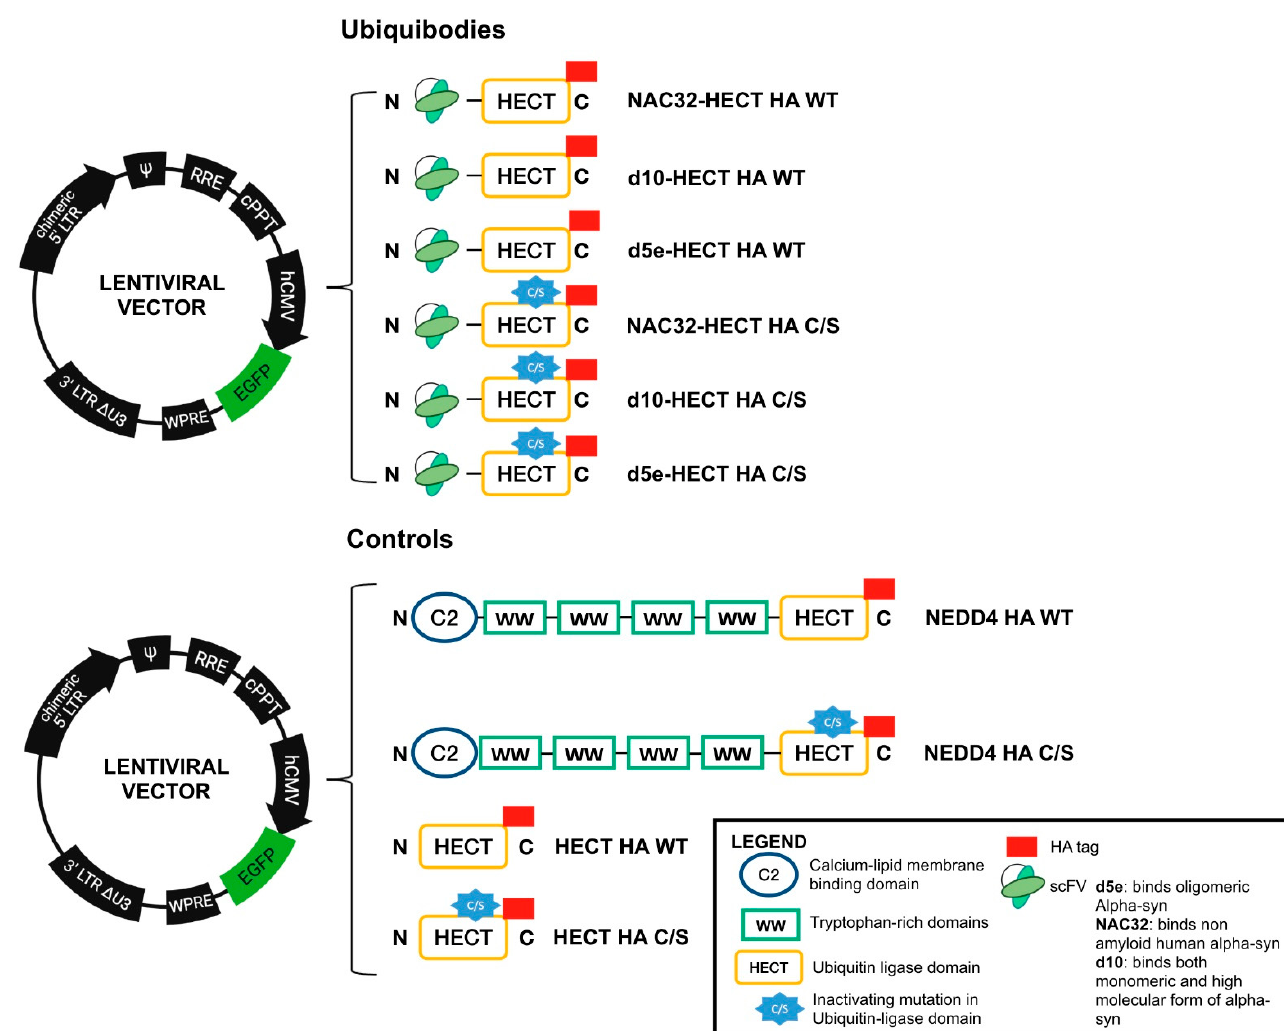
Figure 1. Schematic representation of the developed ubiquibodies, along with the map of the third-generation self- inactivating LV adopted in this